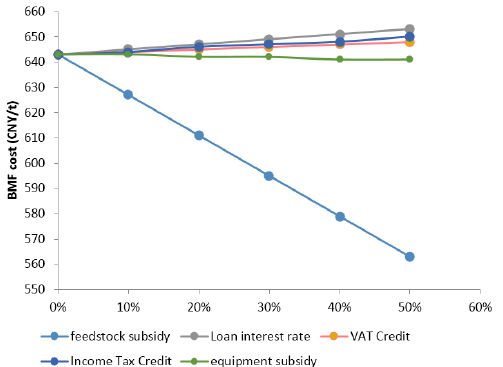
Figure 12 . Impact of various BMF incentive options. Note: the variation of each policy factor is based on current incentive measures in China: (1) feedstock subsidy: From 0 USD/t to 22 USD/t (in the figure as 0%–100%); (2) loan interest rate: From 0 to 6.5% (in the figure as 0–100%); (3)VAT credit: From 0% to 100% variation on the base of 14% VAT input rate and 17% VAT output rate; (4) income tax rate: From 0% to100% variation on the base of 25% income tax rate; (5) Equipment subsidy: From 0% to 500,000 CNY/t (80,645.16 USD/t, in the figure as